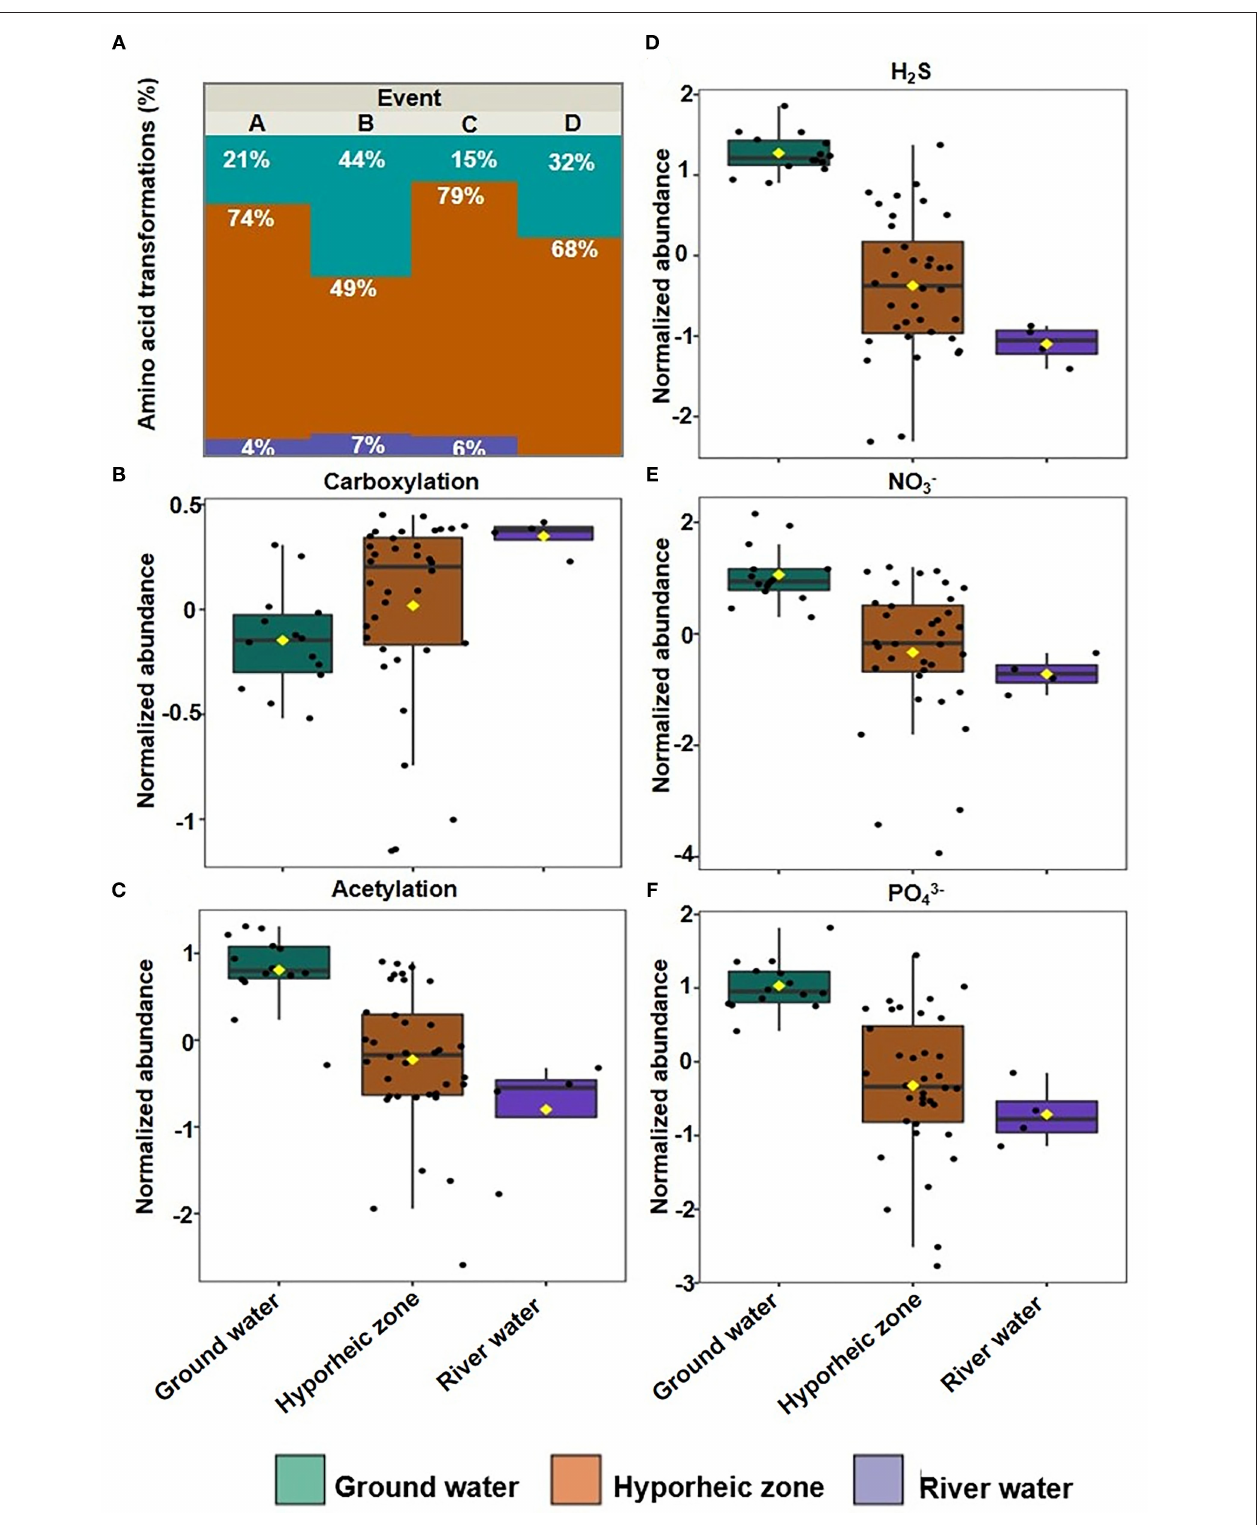
FIGURE 6 | (A) Bar plot of the relative abundance of putative amino acid transformations in each system grouped over four stages (A–D); Box plot of normalized abundance of putative (B) carboxylation, (C) Acetylation, (D) H 2 S, (E) NO − 3 , and (F) PO 3 − 4 transformations in each system grouped over four-time intervals.